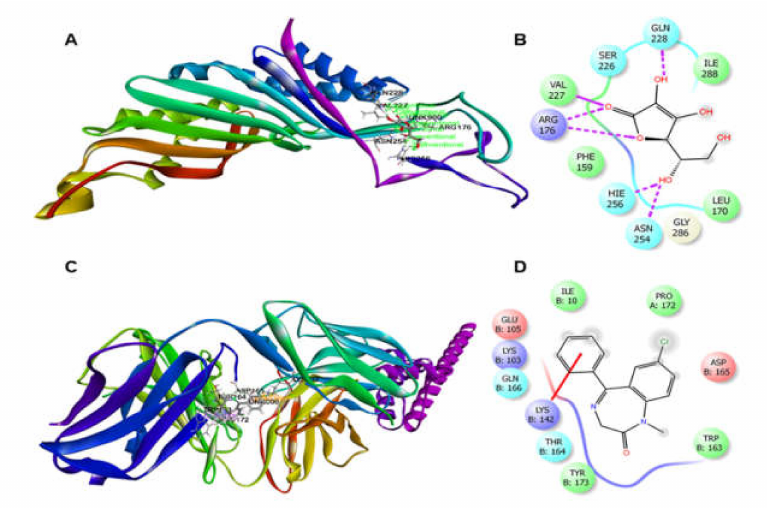
Figure 7. ( A ) Best ranked pose and ( B ) 2D interaction diagram of ascorbic acid docked at the binding pocket of xanthine oxidoreductase (PDB: 1R4U). ( C ) Best ranked pose and ( D ) 2D interaction diagram of diazepam docked at the binding pocket of potassium channel (PDB: